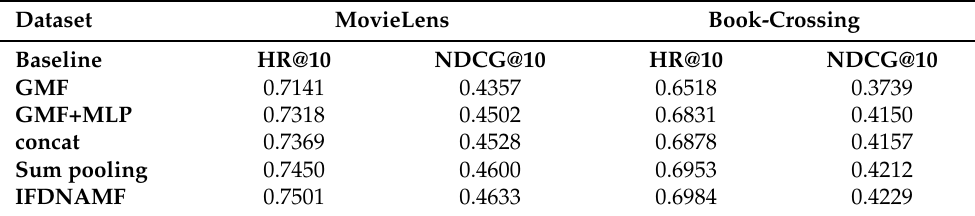
Table 1. The performance of the five models on MovieLens and